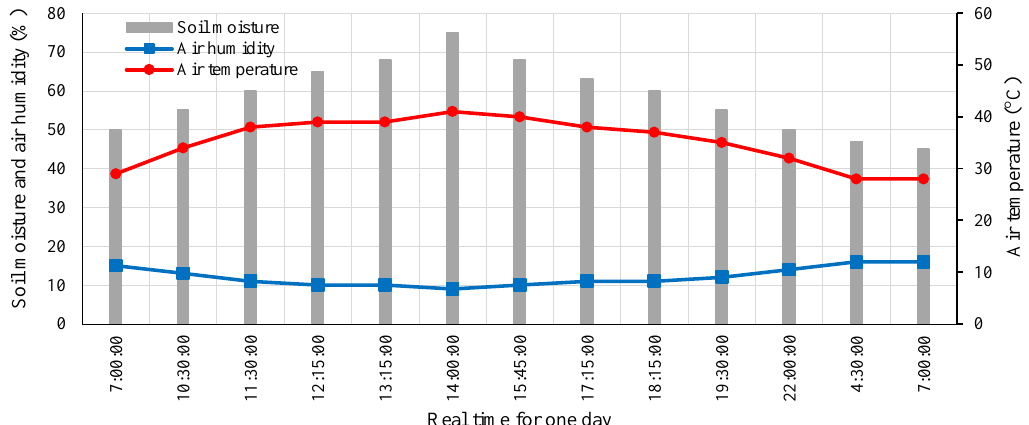
Figure 16. Measured and transmitted data regarding climate conditions from the sensor node to the router node by applying the SWORD algorithm.